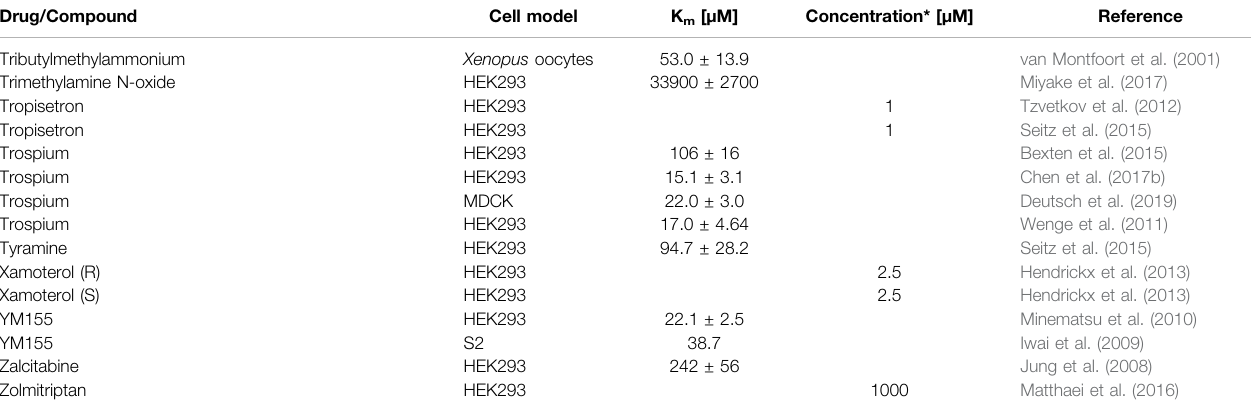
TABLE 1 | ( Continued ) Substrates of OCT1 (drugs, drug metabolites, endogenous molecules, chemicals) studied in single-transfected cell